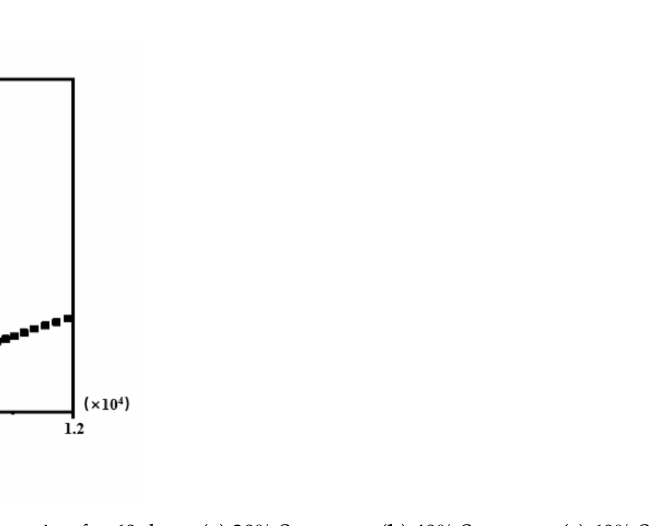
Figure 7. Each coating’s Nyquist pattern for immersion for 60 days: ( a ) 20% Seawater; ( b ) 40% Seawater; ( c ) 60%